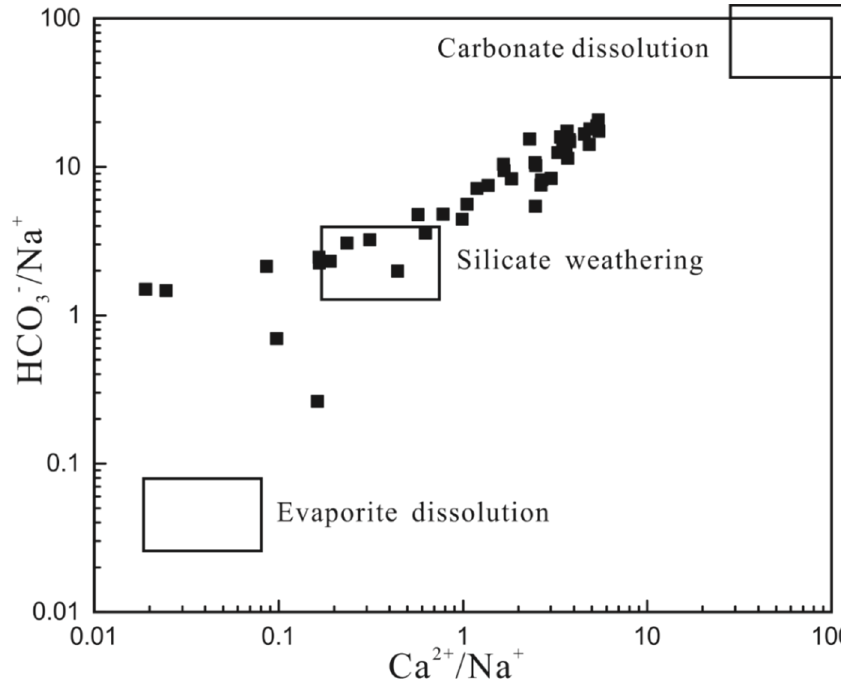
Figure 5. Gaillardet diagram for the groundwater in the study area.